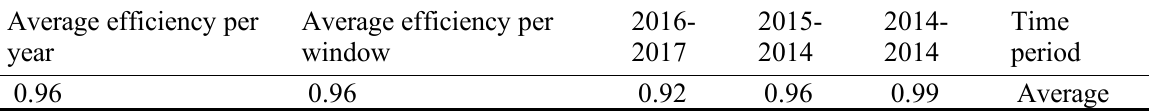
Table 3 . Results of efficiency assessment with window data envelopment analysis in Zabol County